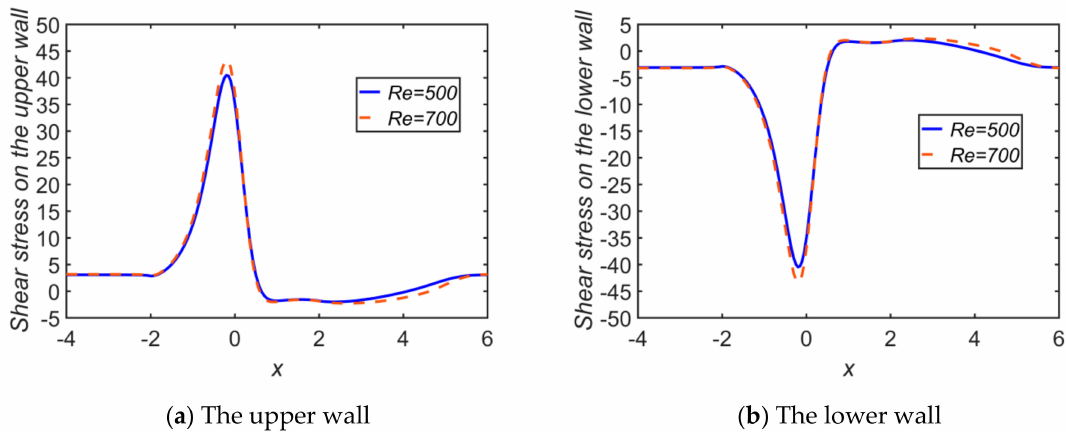
Figure 16. Comparison of WSS for Re = 500 and 700 in case of Cu – SWCNT /water, setting M = 5, Pr = 1, Rd = 0.2, and φ = 0.02, at t =